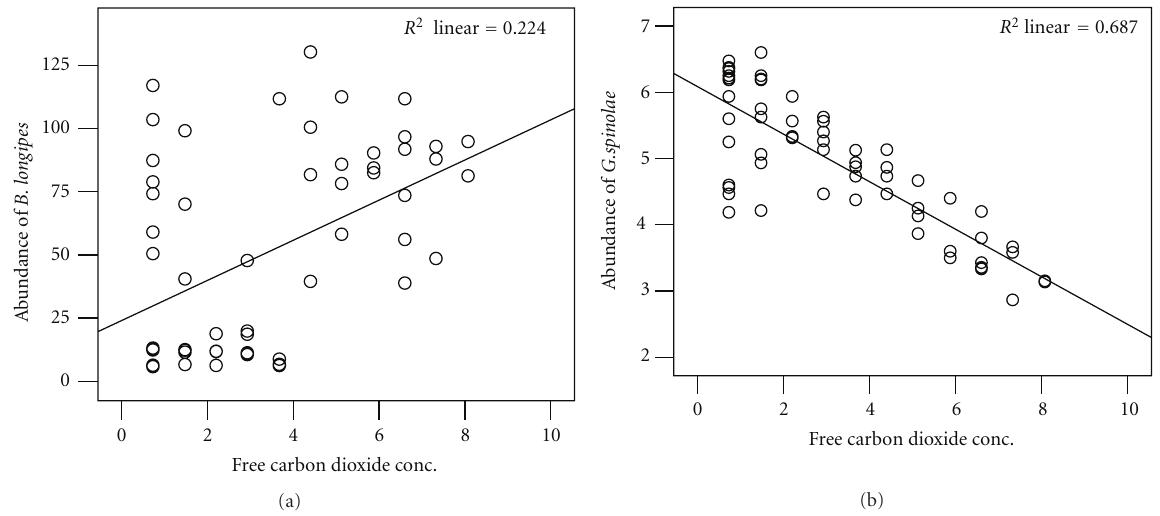
Figure 5: Relation between free carbon dioxide and abundance of (a) Brachydeutera longipes (Hendel) and (b) Gerris spinolae (Lethierry and Severin) as shown by regression